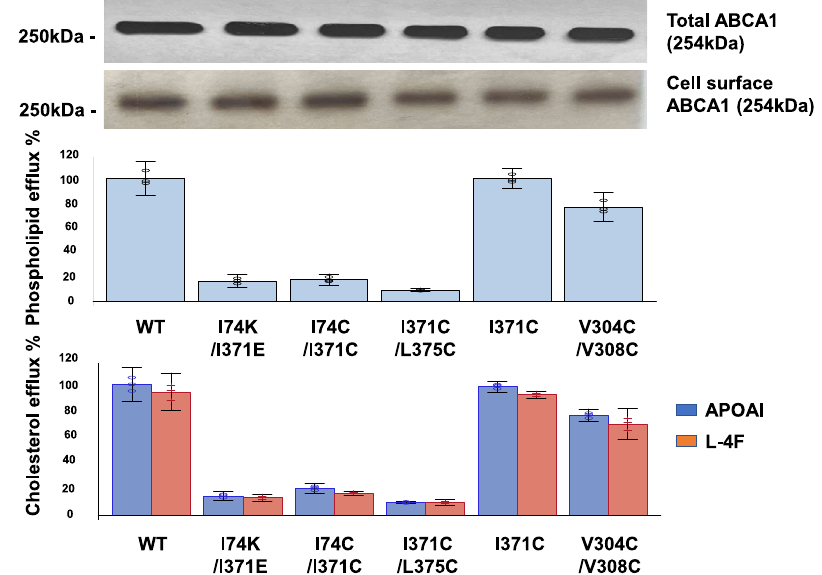
Fig.5|PLandcholesterolef fl uxbyWTABCA1andABCA1withmutationsinthe annulus and annulus ori fi ce. WT and mutated ABCA1s (I74K/I371E, I74C/I371C, I371C/L375C,I371C,V304C/V308C)expressedinBHKcellswereincubatedfor4hat 37°C with APOA1 or an equal weight of the APOA1-mimetic peptide, L-4F. PL and